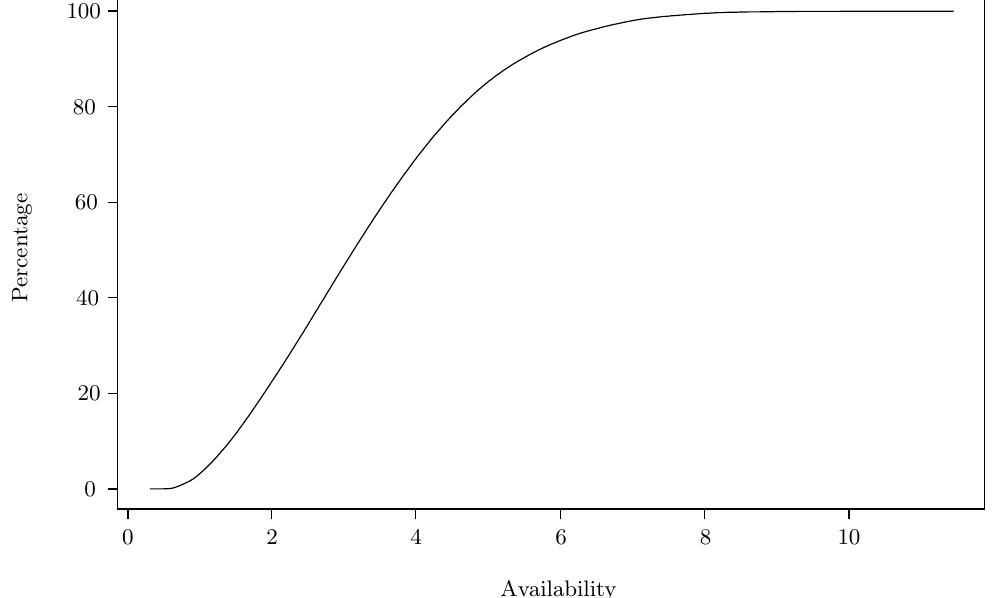
Figure 7: Percentage design space below percentage time offline